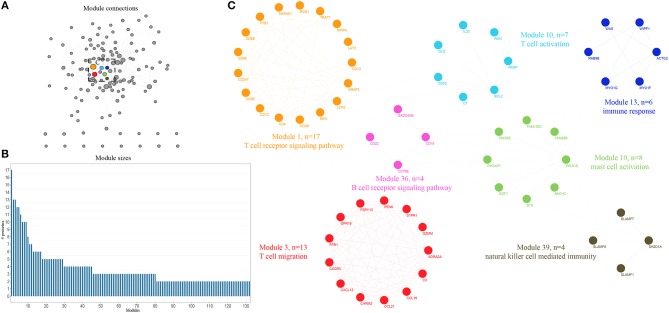
Expression profiling of whole proteome reveals co-expression clusters and functional modules in bladder cancer. (A) Allocation of 132 modules. Each node represents the individual module and their interactions by the module size. Edges connect modules that share PPIs. Boxed modules are further enlarged in (C). (B) Distribution of modules size, modules were identified by superimposition of proteins in bladder cancer onto the PPI network. The numbers of members from each module are exhibited in the figure. (C) Seven interconnected modules of immune reaction system derived from bladder cancer, with showing the protein names and representative functional terms.